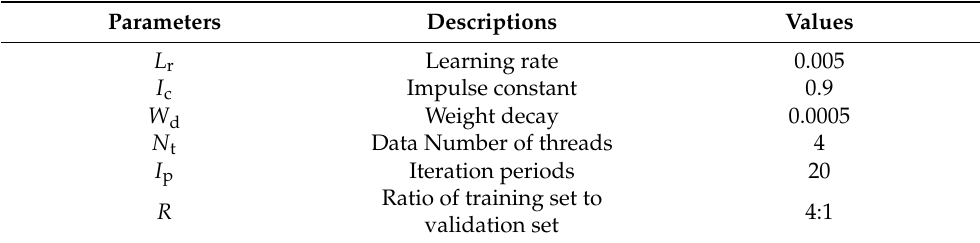
Table 1. Setting parameters of vehicle detection network.